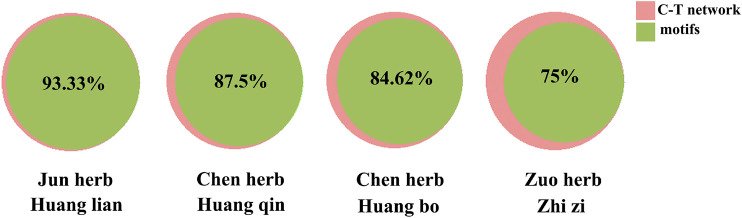
Venn diagram was used to visualize the overlap number between C-T-P network and communities in HJD, the pink represents the C-T-P network, and the green represents communities.